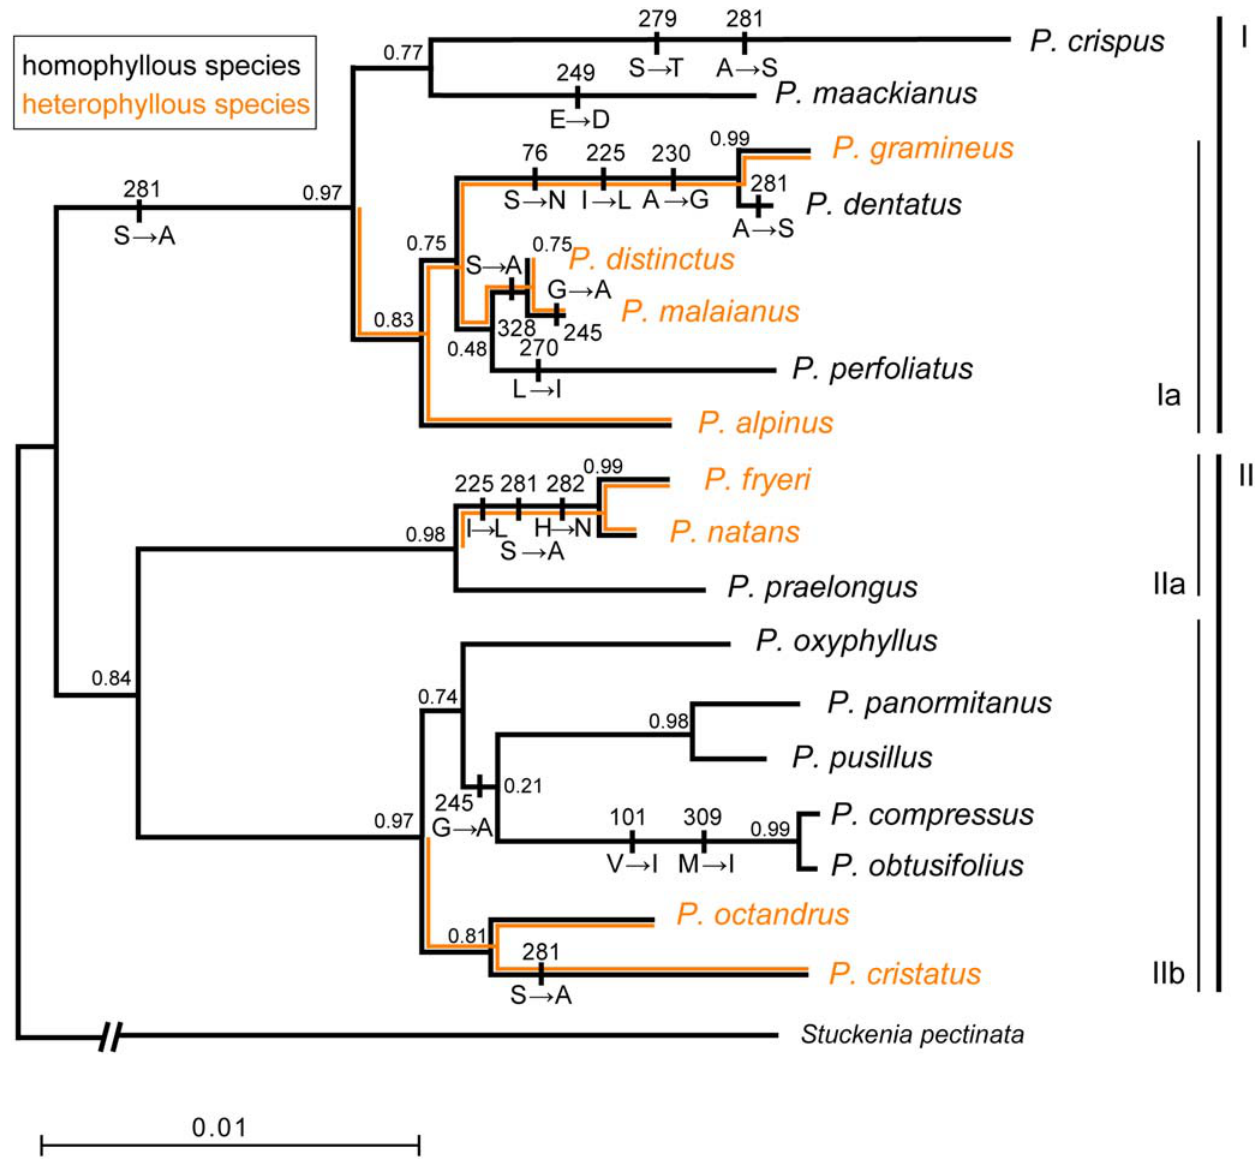
Figure 1. Maximum likelihood Potamogeton cpDNA tree based on a combined 4394-bp chloroplast DNA dataset. Approximate likelihood-ratio test measures (aLRT) are indicated as support for branches [52]. Amino acid replacements of RbcL reconstructed under the codon substitution model (M8) are also indicated. Branches with orange lines indicate three heterophyllous lineages, whereas the others were homophyllous